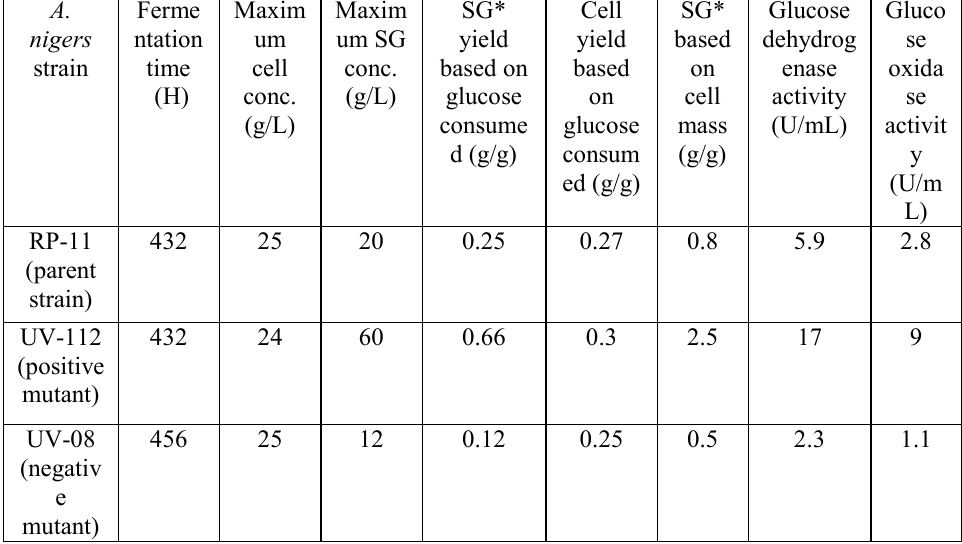
Table 1. Performance of Sodium gluconate (SG) mutants and the parent strain